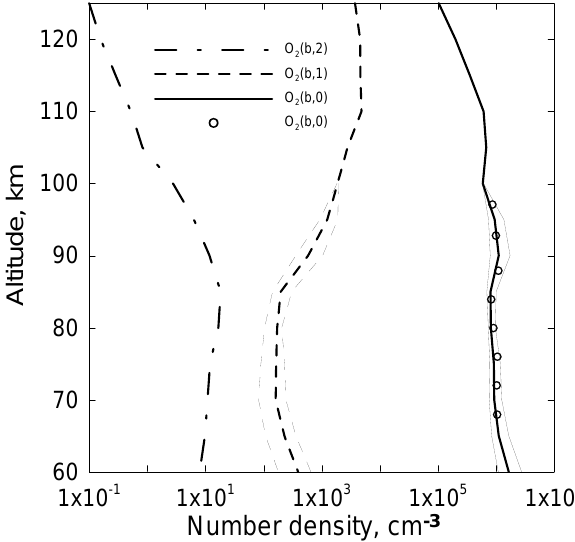
Fig. 2. Altitude profiles of the number densities of the molecules in the state O 2 (b 1 6 + g , v) for v=0, 1 and 2. Circles – experimental data of METEORS for O 2 (b 1 6 + g , v=0) (Mlynczak et al., 2001). The bold curves – calculations for the conditions of experiment METE- ORS in accordance with our model. The altitude profiles of the number densities of molecules in the states O 2 (b 1 6 + g , v) for v=0 and 1, calculated for two ozone altitude profiles [O 3 ] 0 at variations of [O 3 ] 0 /[O 3 ] equal to 0.5 and 2.0, are shown by thin grey